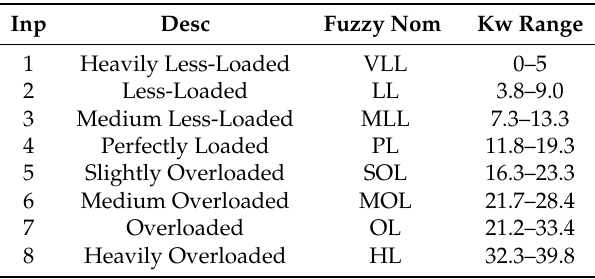
Table 1. Input fuzzy